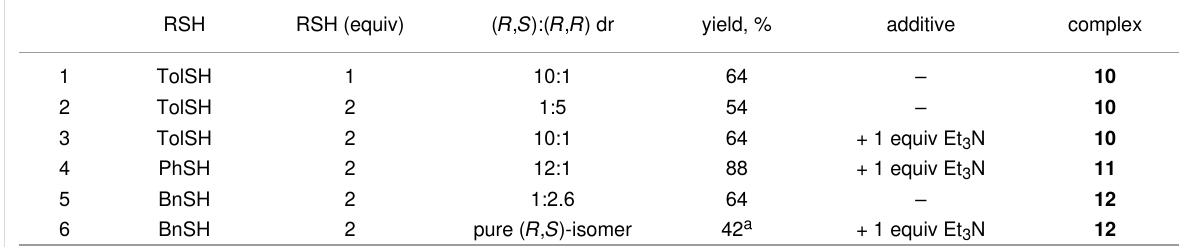
Table 2: Yield and diastereomeric ratio of the cysteine derivatives obtained in a one-pot electrochemical reduction (method B: − 1.5 V (Ag/AgCl,